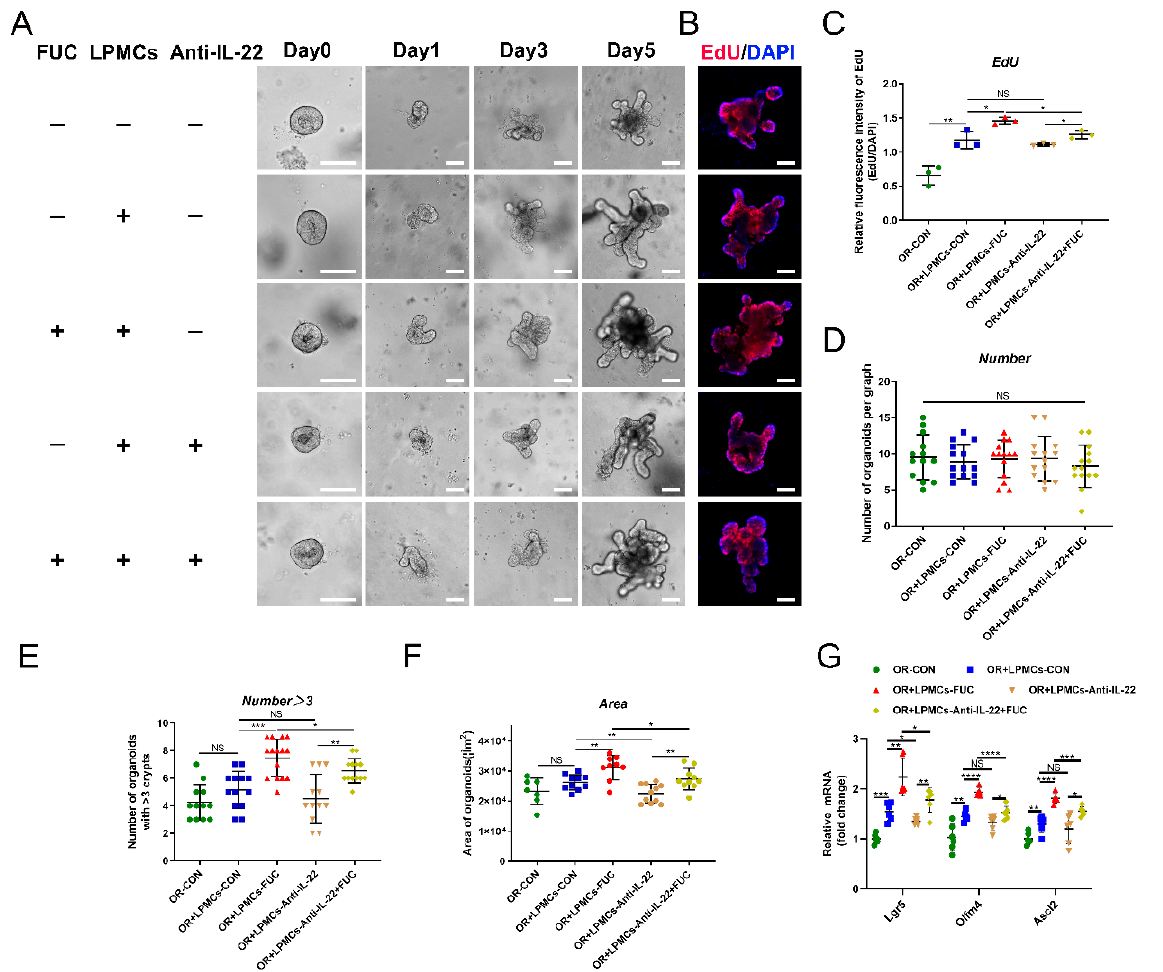
Figure 6. Enhanced ISC proliferation via IL-22 from LPMCs after L-fucose treatment. ( A ) Repre- sentative images of LPMC and intestinal organoid coculture experiments (scale bar, 100 μ m). ( B ) EdU staining of organoids (scale bar, 100 µ m). ( C ) Quantitative analysis of EdU fluorescence intensity. ( D ) Number of organoids per field of view. ( E ) Number of organoids with more than 3 buds per graph. ( F ) Average area of organoids per graph. ( G ) qRT-PCR analysis of Lgr5, Olfm4 and Ascl2 in organoids. Data are expressed as the mean ± SD. * p < 0.05, ** p < 0.01, *** p < 0.001, **** p < 0.0001; NS, no significance. +, with . − , without.